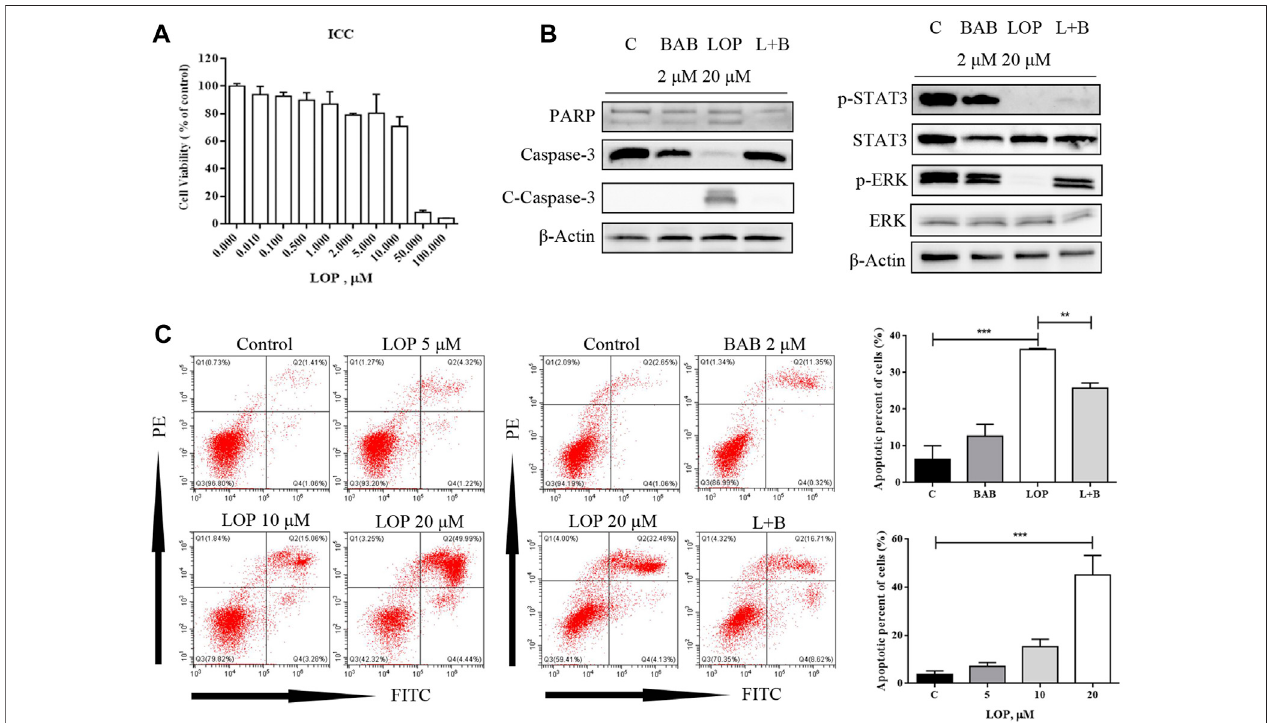
FIGURE 8 | BAB can reverse the apoptosis of interstitial cells of Cajal (ICC) induced by loperamide. (A) CCK-8 method showed that loperamide could also induce concentration-dependent apoptosis in ICC at 24 h; (B) the expression of apoptosis-related caspase pathway proteins and the activation of STAT3 and ERK were detected by Western blotting; (C) apoptosis was detected by fl ow cytometry. ** p < 0.005, *** p <